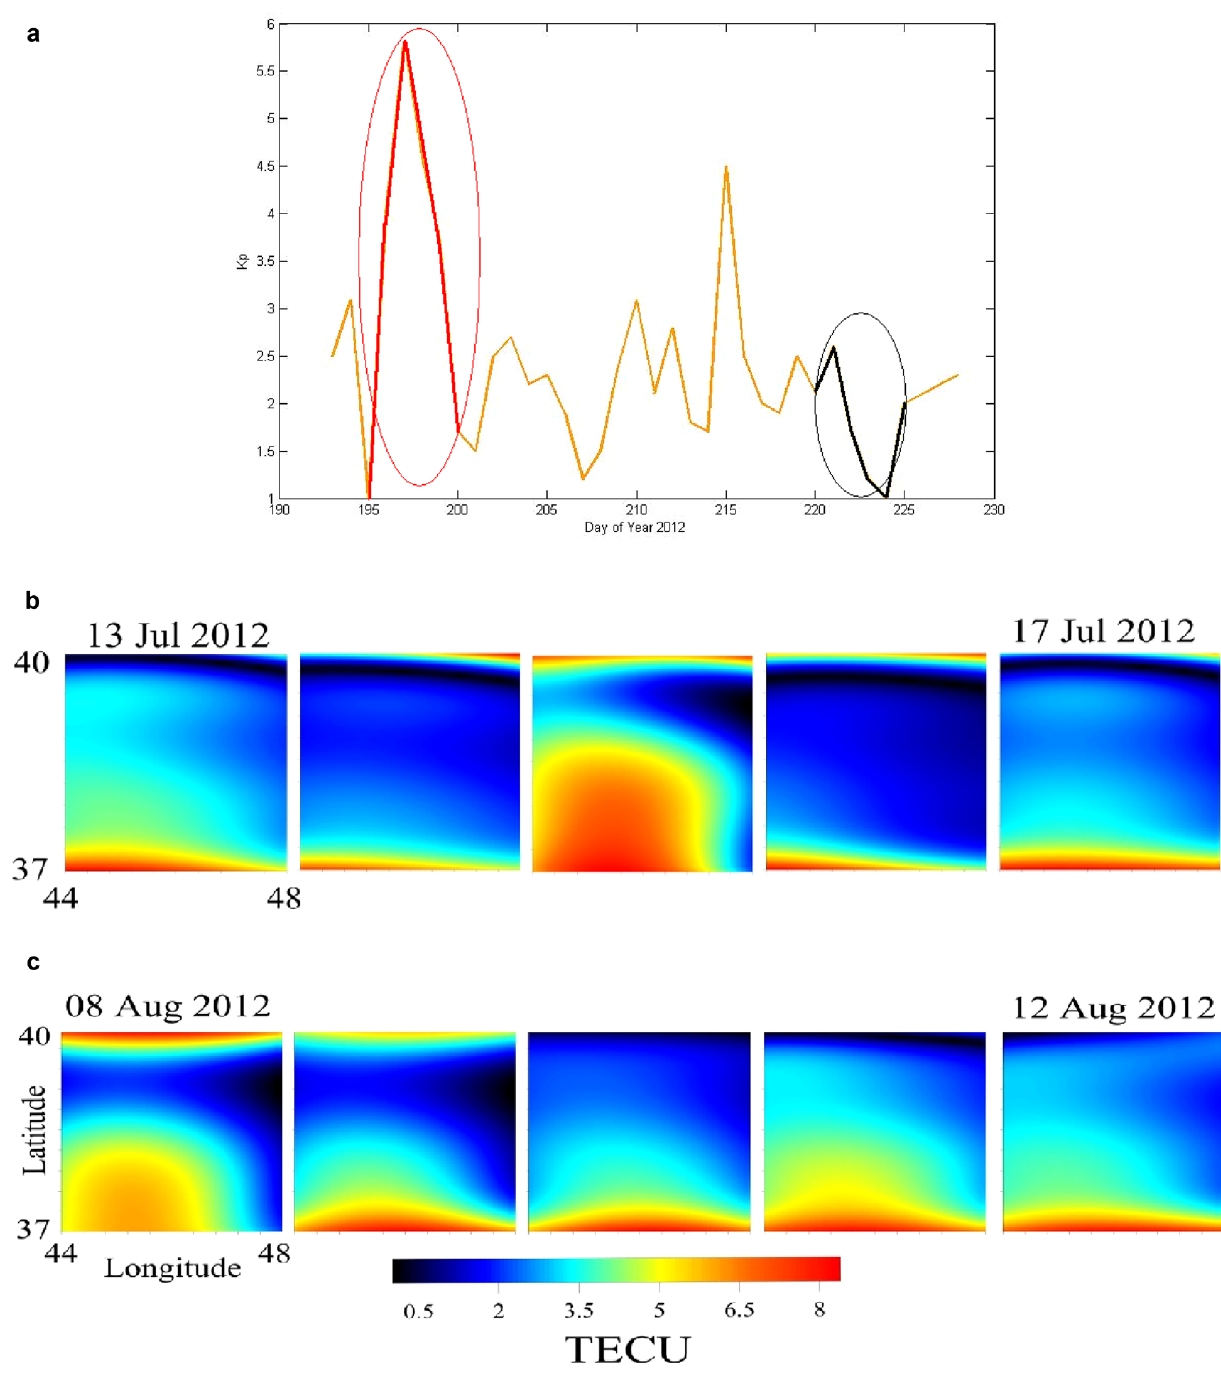
Fig. 3 a Geomagnetic activity from 11 JUL 2012 to 15 AUG 2012, red and black ellipse shows the range of PHGSA and PLGSA processed in this study, respectively b TEC of PHGSA c TEC of